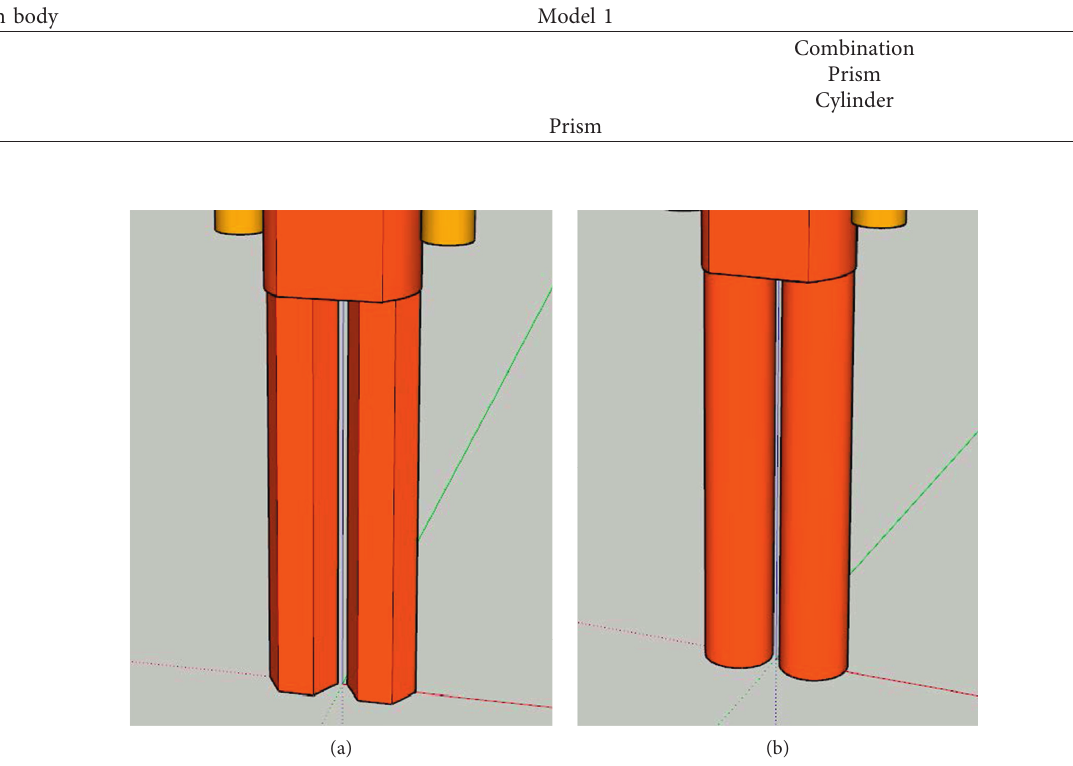
Figure 14: Two optional leg shapes. (a) Prism. (b)